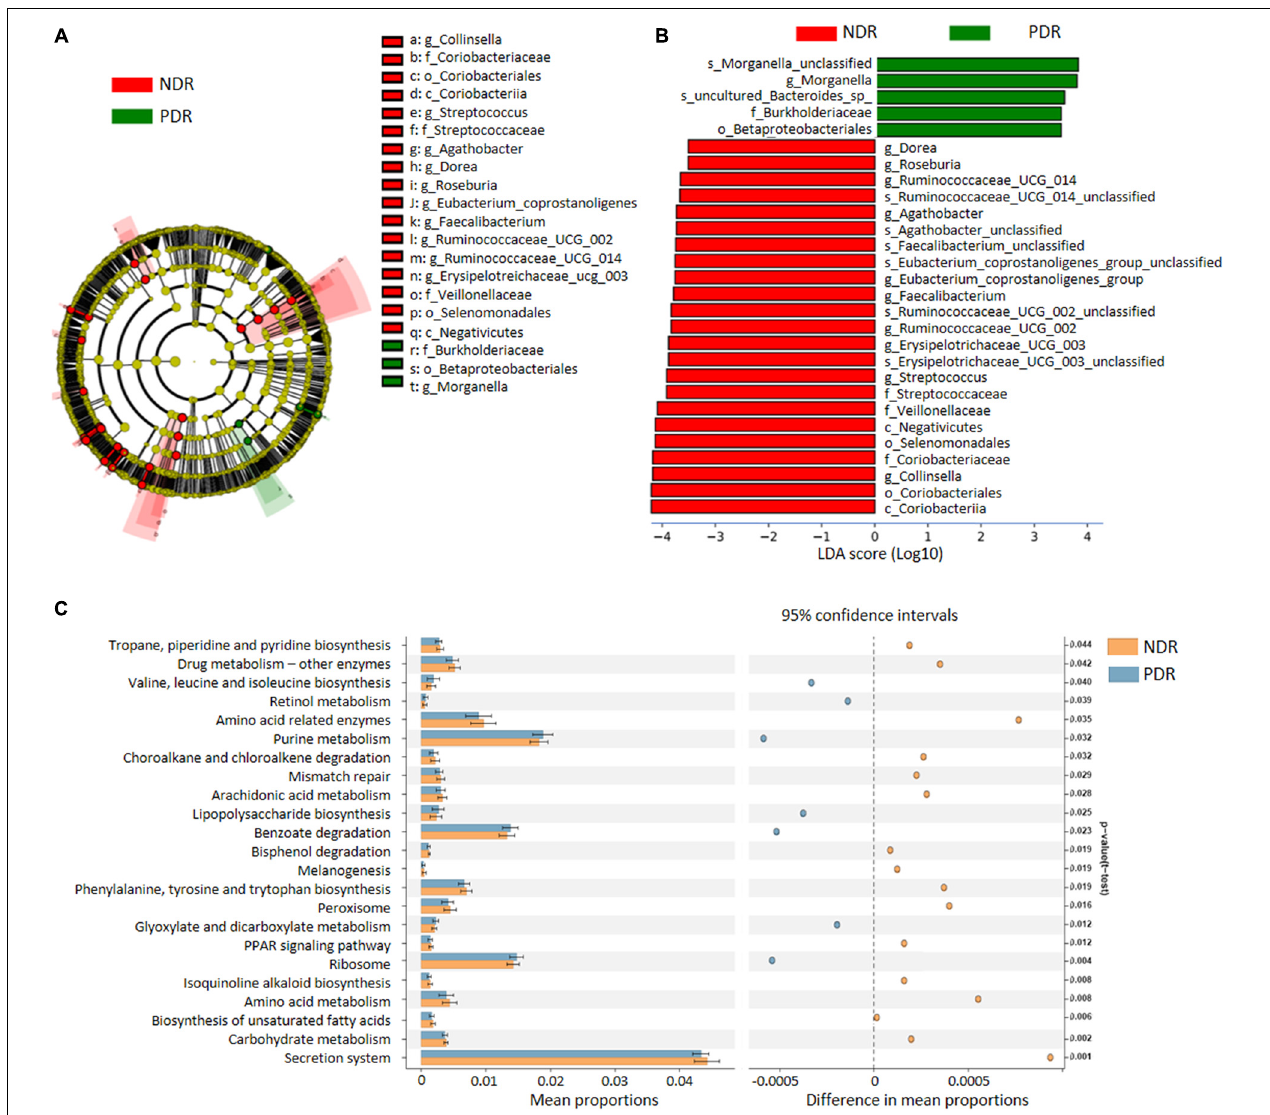
FIGURE 2 | The discriminative operational taxonomic units and the predicted function. (A) The phylogenetic distribution of gut microbiota correlated with the two groups as shown by cladogram using LDA effect size analysis. (B) The differences of gut microbiota in abundance between the two groups (LDA > 3.5). (C) KEGG pathways predicted by PICRUSt analysis. PDR, proliferative diabetic retinopathy; NDR, diabetic patients without retinopathy; LDA, linear discriminant analysis; PICRUSt, phylogenetic investigation of communities by reconstruction of unobserved